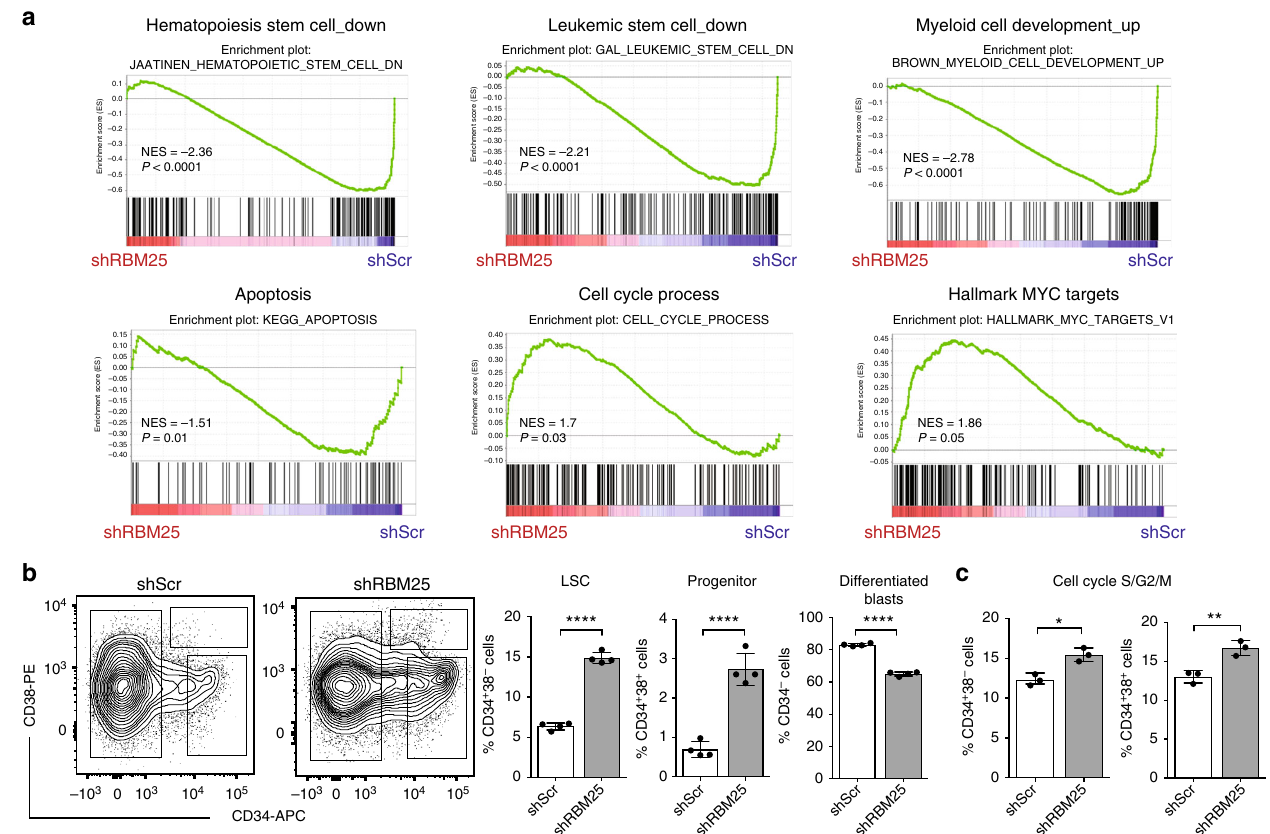
Fig. 4 RBM25 knockdown alters the proliferation and differentiation status of human AML cells. a GSEA plots showing enrichment of the indicated gene sets in RBM25 KD vs. control U937 cells. b Representative fl ow cytometry plots depicting changes in CD34 + and CD38 + levels upon RBM25 KD and quanti fi cation of the relative representation of LSCs (CD34 + CD38 − ), progenitors (CD34 + CD38 + ) and differentiated blasts (CD34 - ) after RBM25 KD in human 8227 AML cells (data represent the mean ±s.d., n = 4). c Cell cycle analysis on indicated populations of 8227 cells following RBM25 KD as assessed by PI staining (data represent the mean±s.d., n = 3). Data were subjected to an unpaired t test and asterisks indicate the following: * P <0.05; ** P <0.01; **** P <0.0001. Panels ( b ) and ( c ) show representative results of two independent experiments. All replicates in ( b ) and ( c ) are biological